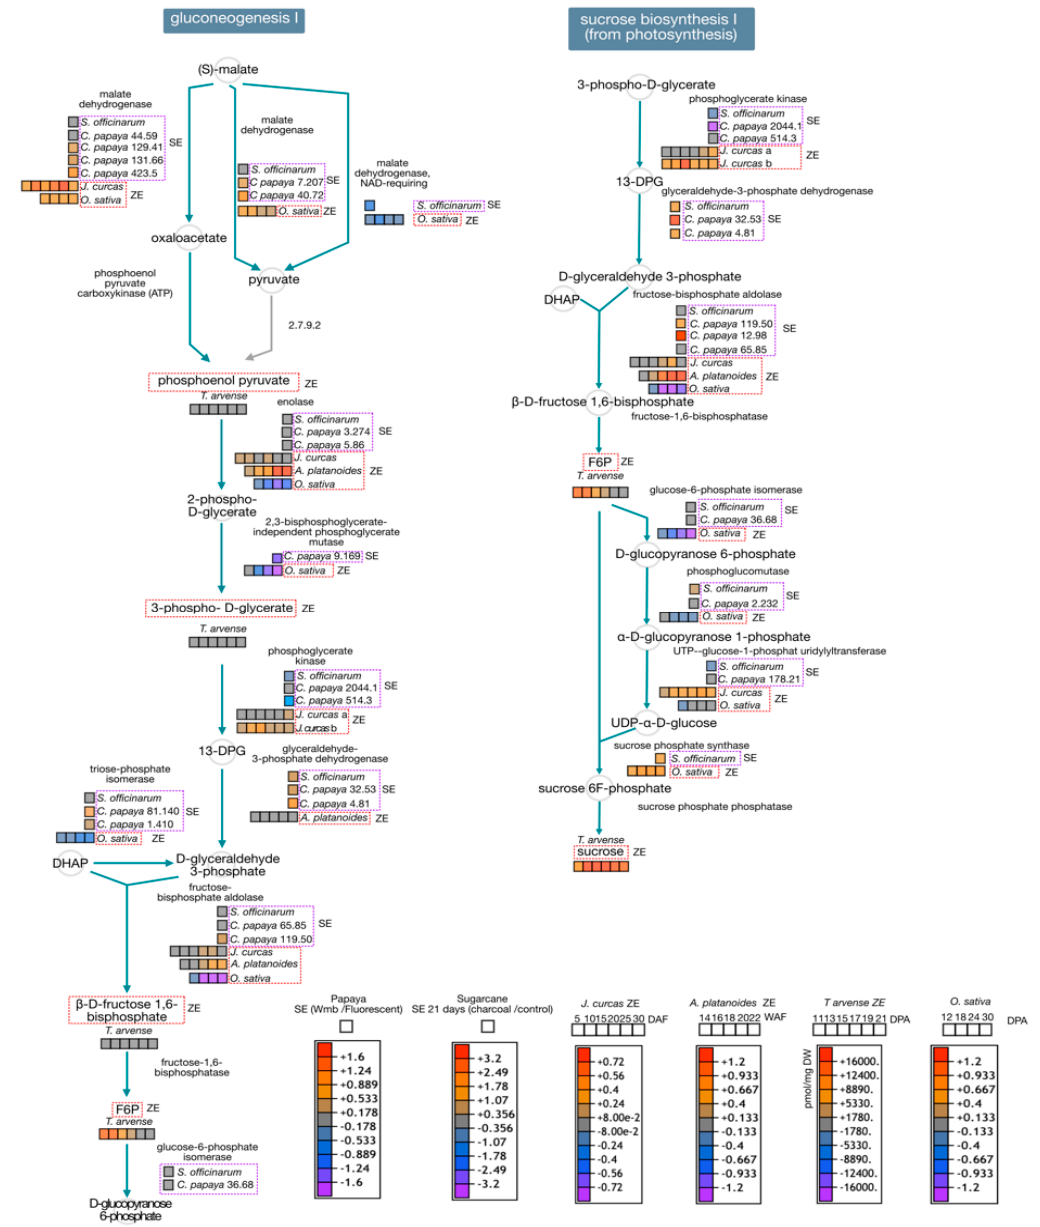
Figure 5. Visual representation of gluconeogenesis, and sucrose biosynthetic metabolic pathways highlighting the maturation stage of somatic and zygotic embryos. We used Arabidopsis homolog proteins for J. curcas , A. platanoides, S. officinarum and O. sativa . We built the metabolic pathways as indicated in Figure 4.